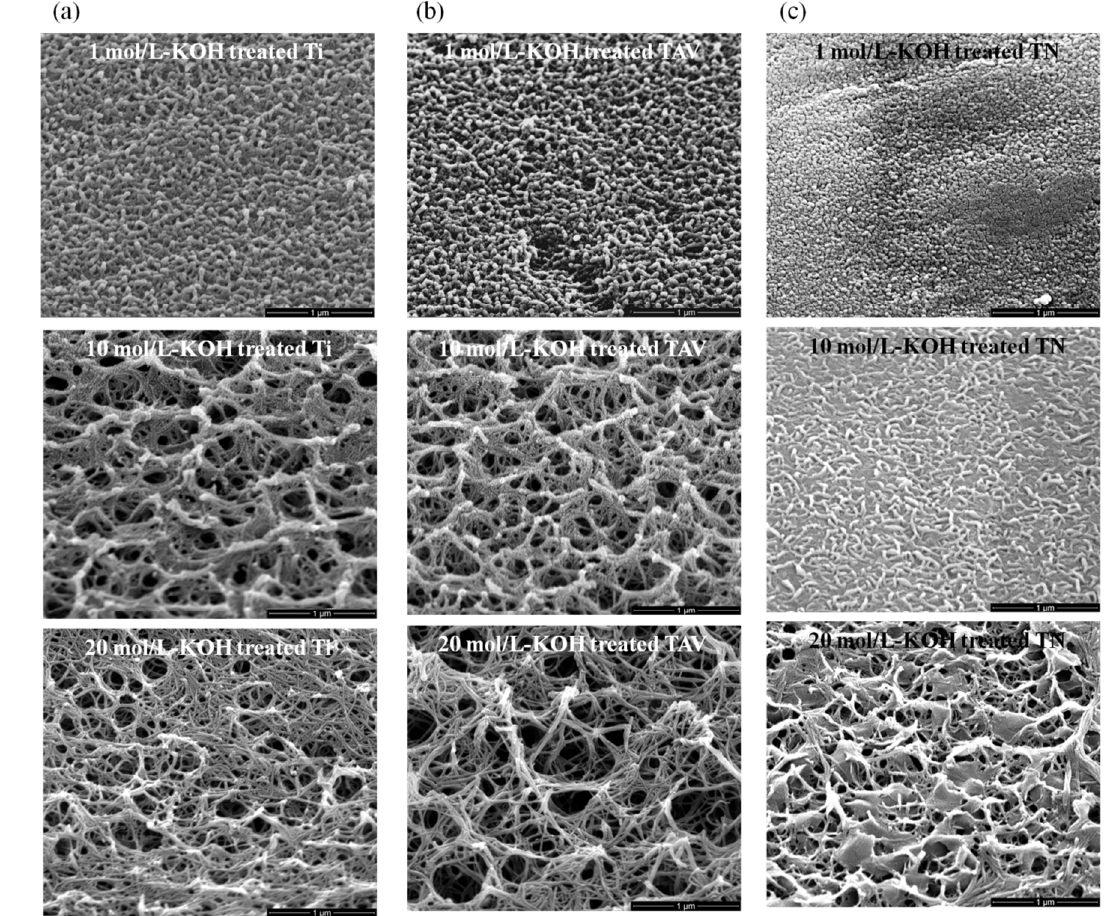
Figure 1. 45° tilted scanning electron microscope (SEM) images of synthesized nanostructure. ( a ) SEM images of the Ti series after KOH treatment; ( b ) SEM images of the TAV series after KOH treatment; ( c ) SEM images of the TN series after KOH treatment. Ti and TAV metals which consist of more than 90% of Ti yielded elongated nanostructures of K-incorporated nTOFs (diameter: about 10 to 100 nm, length: several tens of micrometers) using 10–20 mol/L-KOH solution. In contrast, TN metal with 50% Ti content needed a KOH treatment with >20 mol/L-KOH solution. In short, 10 mol/L-KOH-treated Ti & TAV and 20 mol/L-KOH-treated TN showed similar